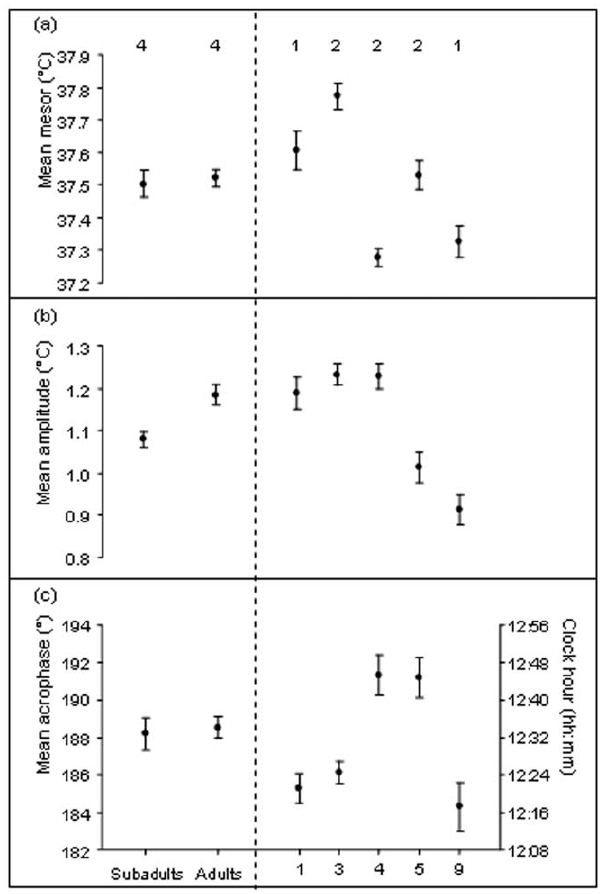
Figure 7. Mean ± SE values of the mesor, amplitude and acrophase shown per age class (subadults and adults) and for different group sizes (1, 3, 4, 5 and 9). The number of individuals in each category is indicated above the error bars. The parameters have been averaged for the level of individual (per category) and then for all weeks, hence SE is non-zero even when only data from one individual is presented.